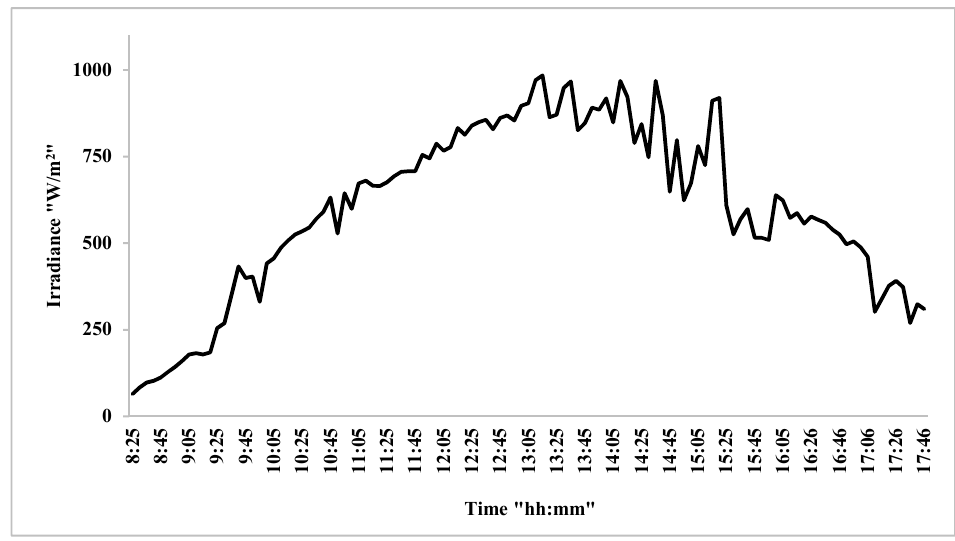
Figure 4. The variation of solar radiation intensity with time.